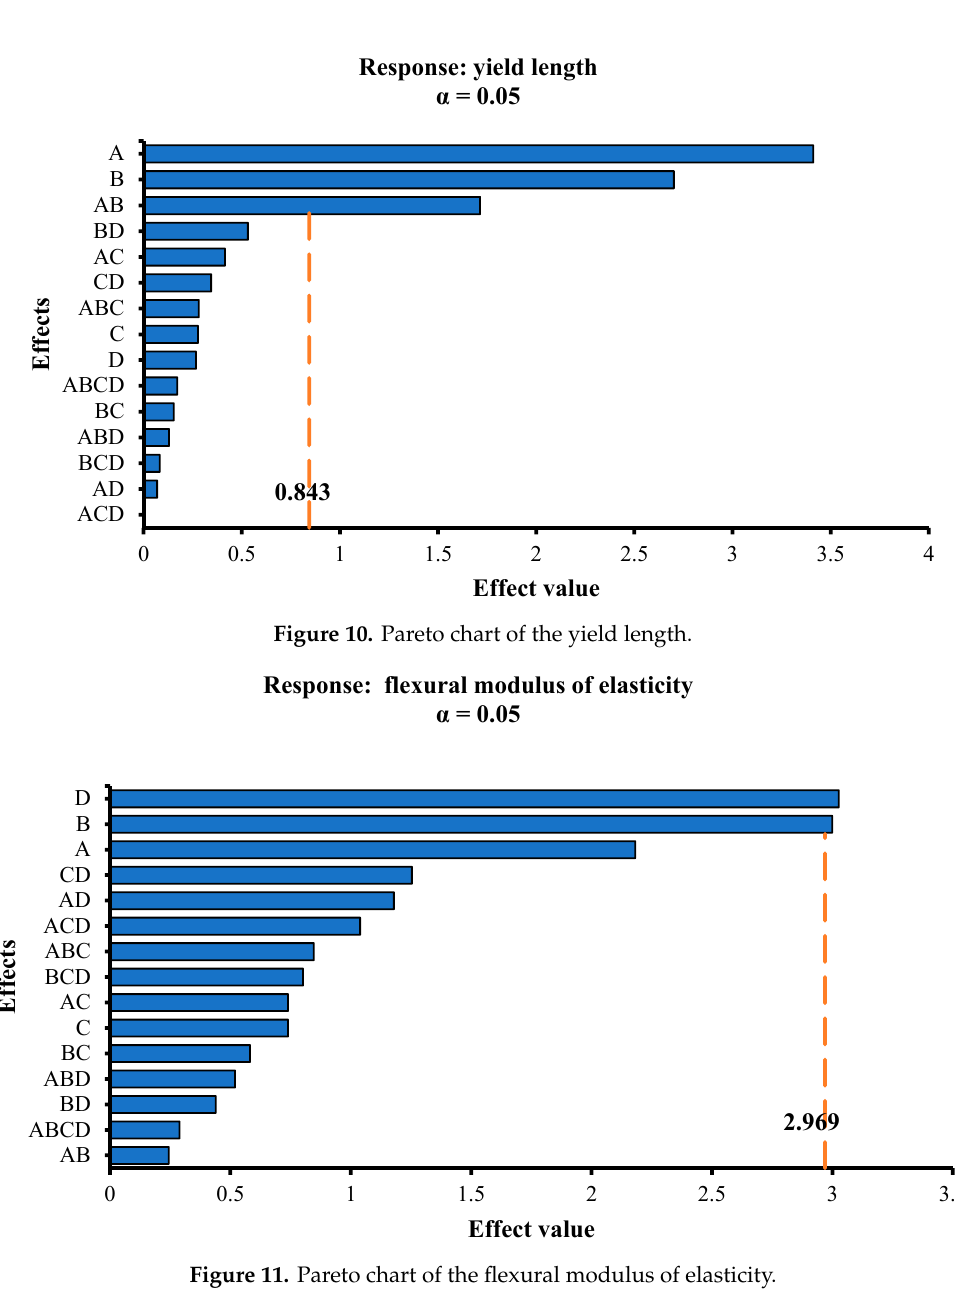
Figure 11. Pareto chart of the flexural modulus of elasticity. Table 5. The values of the main effects of each response.